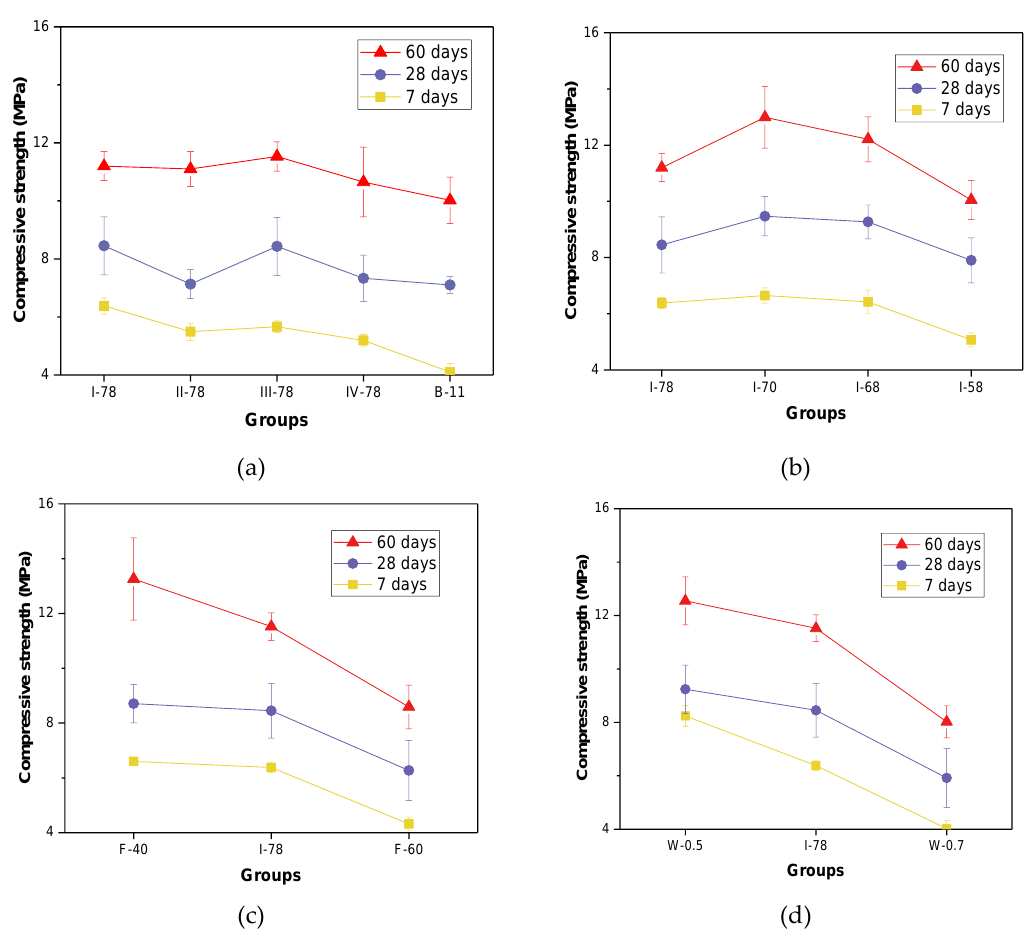
Figure 2. Results of compressive strength for different FGM specimens. ( a ) Coal gangue types and binder volume effect; ( b ) Aggregate gradation effect; ( c ) Fly ash proportion effect; ( d ) Water to binder ratio effect.